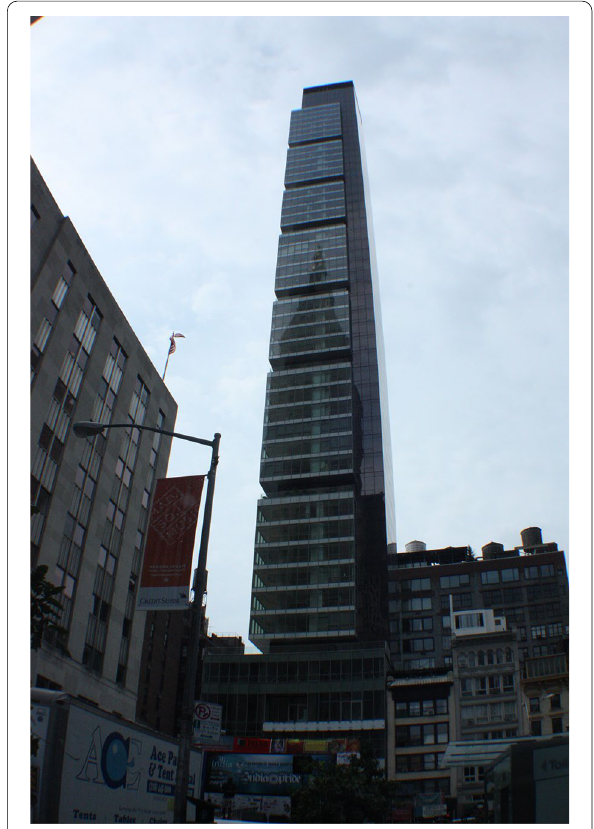
Fig. 27 The shape of the top of the Citigroup Center in New York offers a unique visual